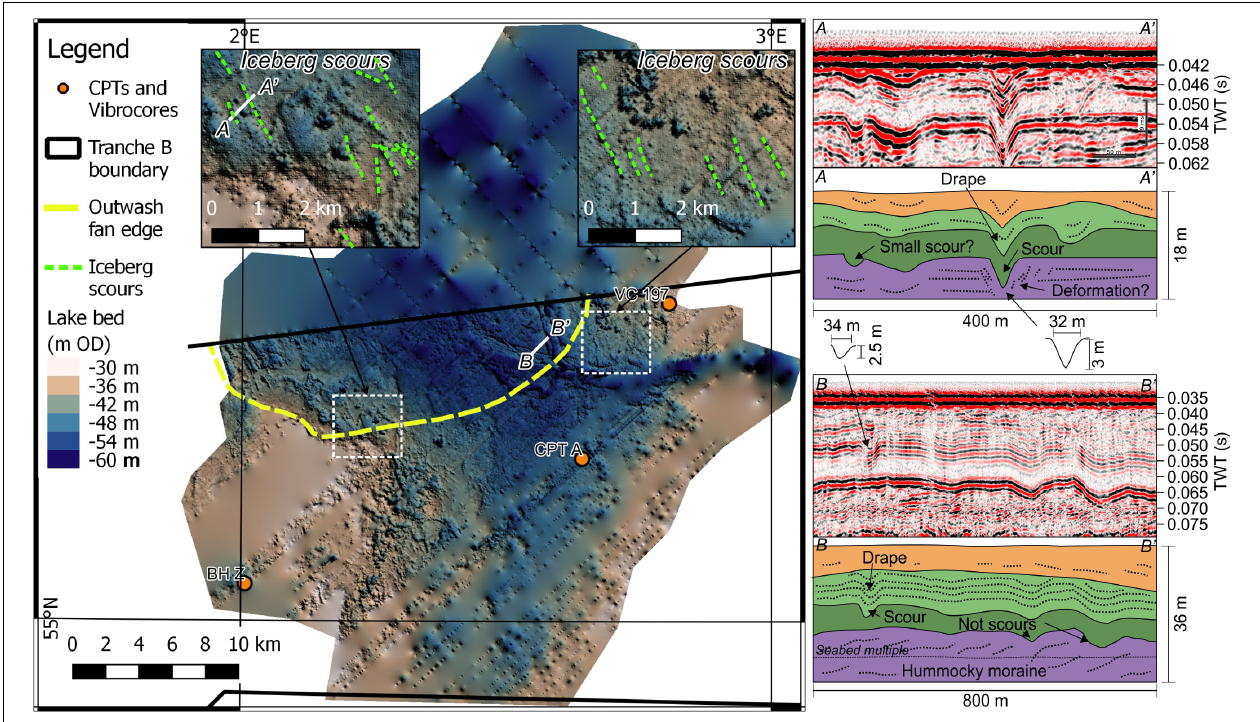
FIGURE 7 | Map of the proglacial lake bed showing its morphology and the presence of iceberg scours. Seismic sections show morphology of iceberg scours as well as lake-bed topography that may appear to be scours in map form. The location of ice-rafted debris found in CPT A is shown. Color bar “La Paz” from Crameri